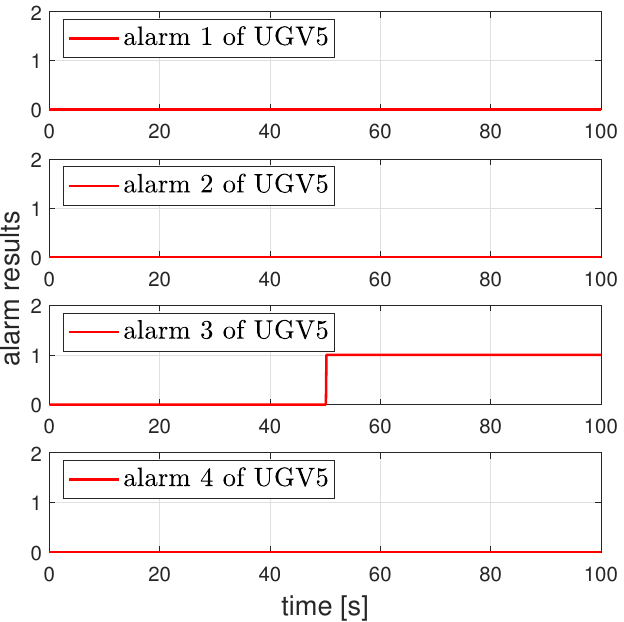
Figure 11. Fault isolation for UGV5. A value of one indicates an actuator fault and the value of zero indicates normal